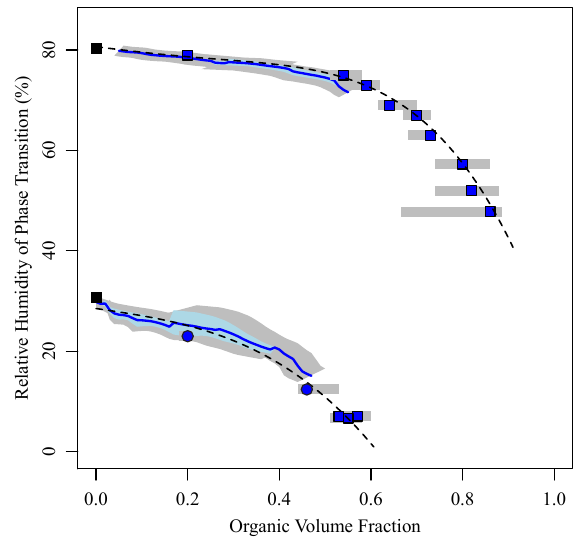
Fig. 4. The deliquescence and efflorescence relative humidities of ammonium sulfate when mixed with isoprene-derived secondary organic material. The solid lines show the DRH( ε ) and ERH( ε ) as derived from data sets like panels (a) / (b) and (c) / (d) of Fig. 2. The lines represent the mean across all collected data sets, and the shading around the lines represents the minimum and maximum of the data sets. Squares show DRH( ε ) and ERH( ε ) values derived from the type of analysis represented by panels (a) / (b) and (c) / (d) Figure 4. of Fig. 3. Circles show points derived using the second number– diameter distribution protocol (cf. text). Blue points correspond to isoprene-derived secondary organic material (this study). Black points correspond to pure ammonium sulfate. The dashed lines rep- resent the parameterization equations for DRH( ε ) and ERH( ε ) that are given in Table 1. Gray shaded areas represent the uncertainty in DRH( ε ) and ERH( ε ) values, taking into account ± 1% uncer- tainty in RH and ± 1nm uncertainty in d seed , d mono , and d filter m,+1 m,+1 m,+1 (cf. Tables S4 and S5 for a detailed explanation of the uncertainty